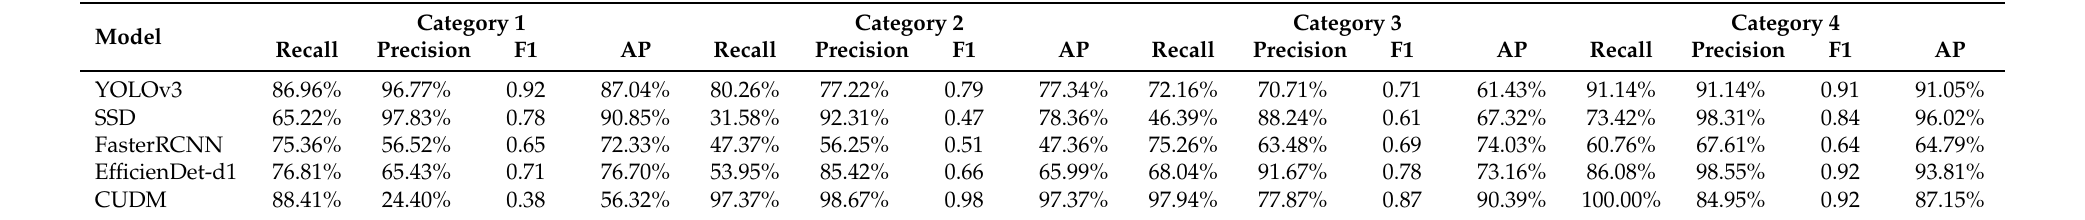
Table 2. Comparison of detection results of four categories of UAVs between CUDM and other